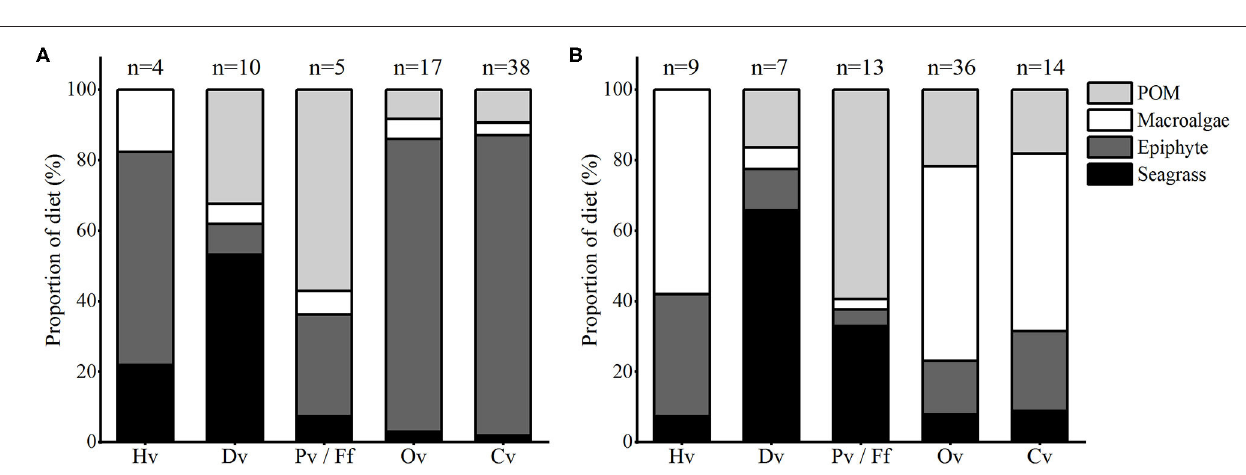
FIGURE 4 | Stacked bar plots showing the mean proportion of the diet contribution of food sources to each trophic group in (A) summer and (B) winter in Xincun seagrass meadow. The lower case letter (n) represents statistical number of each trophic group. Hv, Dv, Pv, Ff, Ov, and Cv represent herbivores, detritivores, planktivores, filter feeders, omnivores and carnivores, respectively. The detailed summary of Bayesian mixing model (SIMMR) outputs and matrix plots of source contribution proportion are given in Supplementary Table 7 , Figure 1 ,